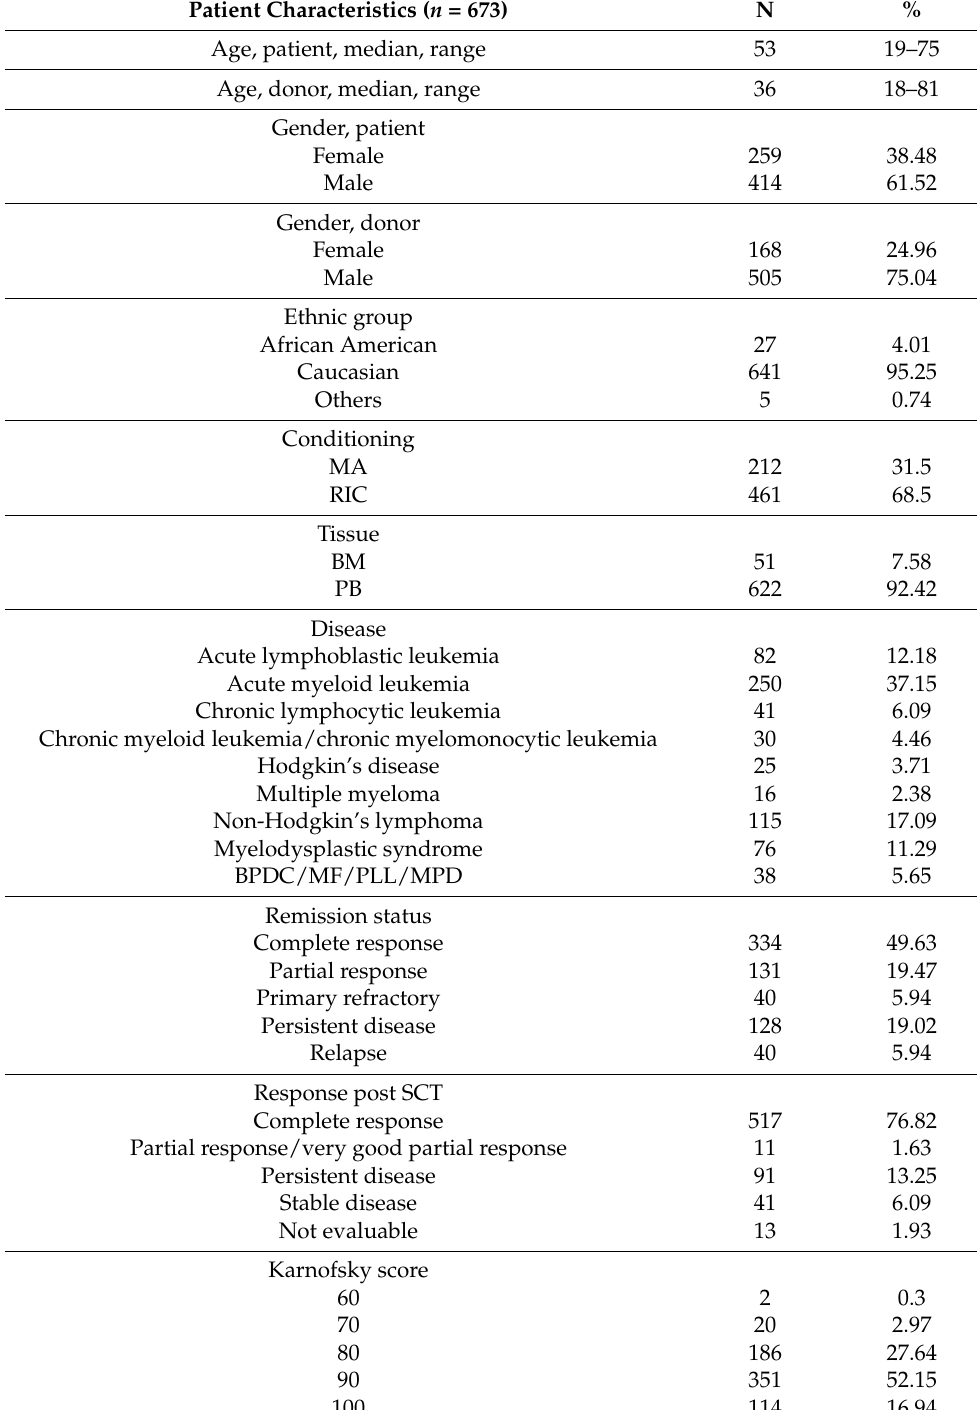
Table 1. Patient and donor